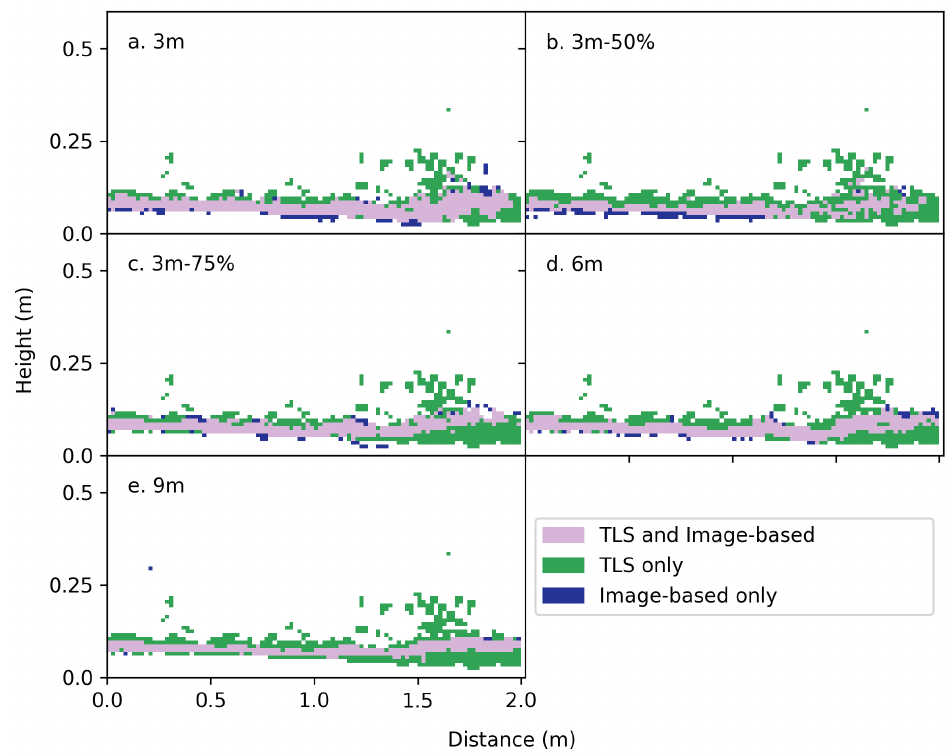
Figure 6. Differences in one horizontal row (2cm wide) between the TLS and image-based voxel representations of the point clouds generated for Plot 1.